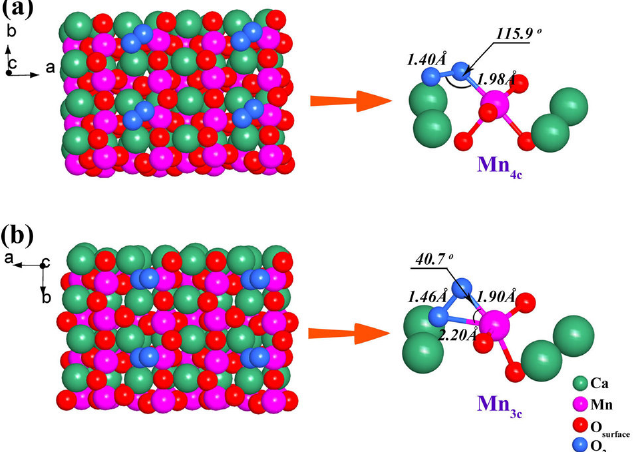
Figure 20. Top view of the configuration of molecular oxygen adsorbed on the ( a ) CaMnO 3 (121) surface and ( b ) CaMnO 2.75 (121) surface. The right parts are the bond length information after oxygen is adsorbed on the surfaces. The green, pink, and red spheres are used to represent Ca, Mn, and lattice O atoms, respectively, and the adsorbed oxygen molecule is shown in blue. (Reprinted from ref. [141] with permission from Inorganic Chemistry. Copyright © 2014, American Chemical Soci- ety).